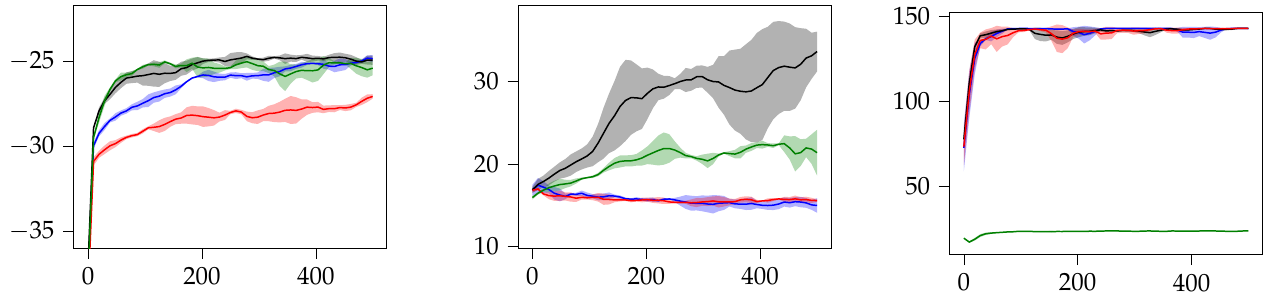
( a ) Total reward during training for the SSDF attack case. Horizontal axis correspond to the TRPO iteration, vertical axis is the average reward ± one standard deviation. From left to right: 1/3/10 ASs. Higher is better.